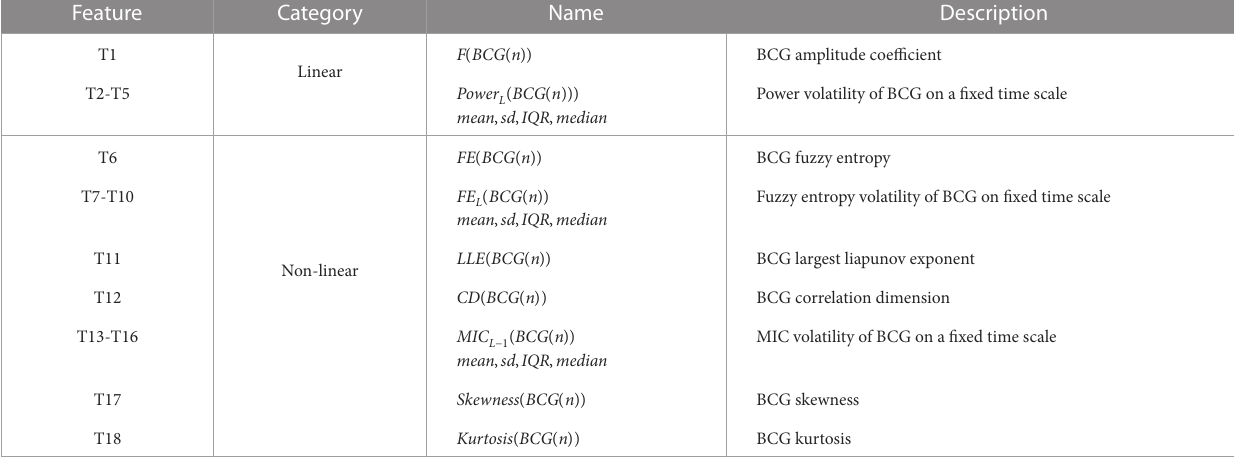
TABLE2 BCGfeatureswithoutlocalizationassistance.sd:standarddeviation.IQR:interquartilerange.